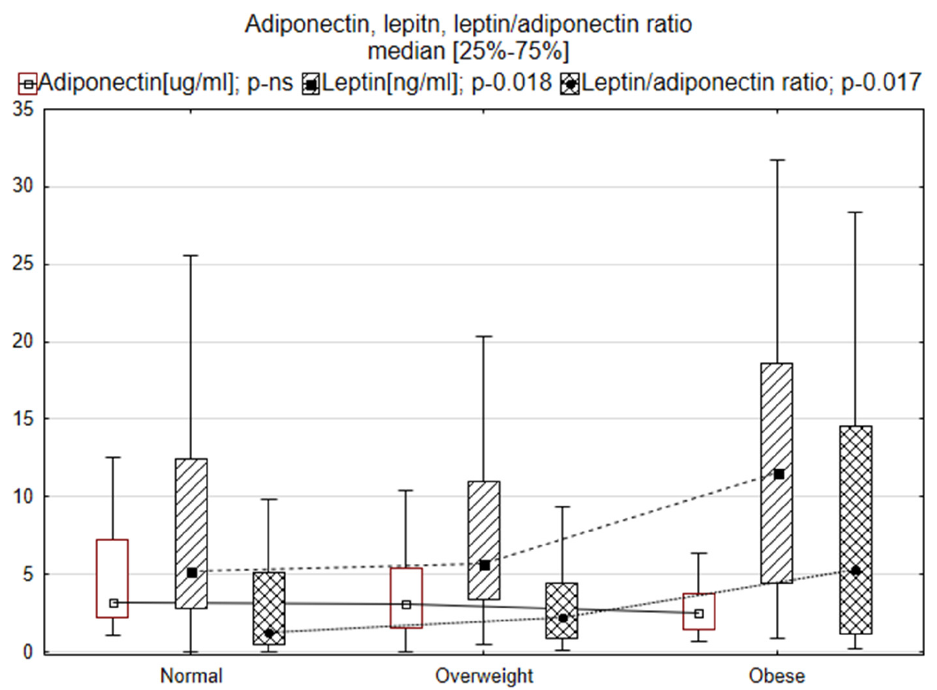
Figure 2. Adiponectin, leptin and leptin/adiponectin ratios in normal-weight, overweight and obese patients.